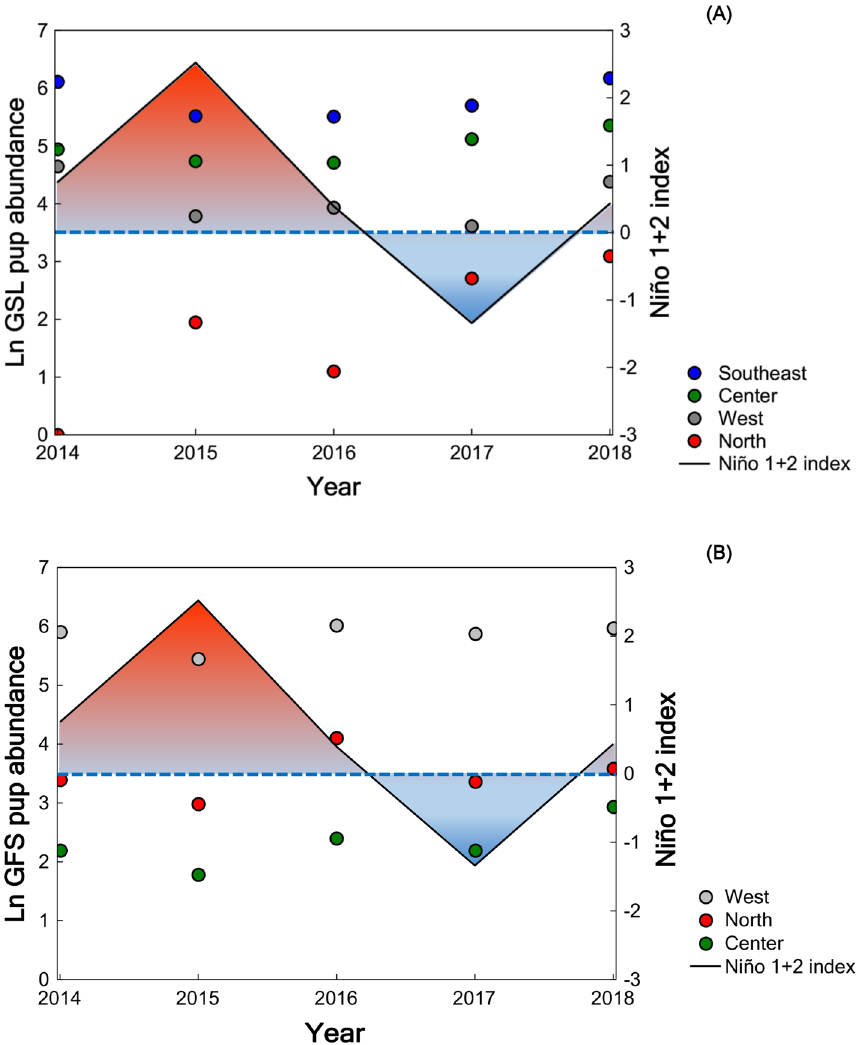
Figure 4. Annual pup abundance per region of the Galapagos Archipelago concerning the El Niño 1 + 2 index. ( A ) Galapagos sea lion. ( B ) Galapagos fur seal. The El Niño 1 + 2 index is the three-month running average of the sea surface temperature (SST) anomalies in the El Niño 1 + 2 region (0–10°S, 90–80°W). The values of the El Niño 1 + 2 index corresponding to October (during the peak in pup births of both species) were plotted for each year and taken from the NOAA website. The Niño El 1 + 2 index indicates the intensity of El Niño (positive values) and La Niña (negative values) events, which can be considered weak (SST anomaly of 0.5 to 0.9), moderate (1.0 to 1.4) or, strong (>